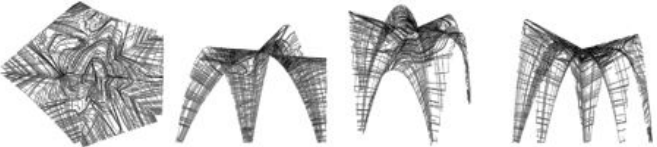
Figure 7. Karamba structure analysis of case study one from the AA showing the stress lines of the shell structure. ofthe shell structure.